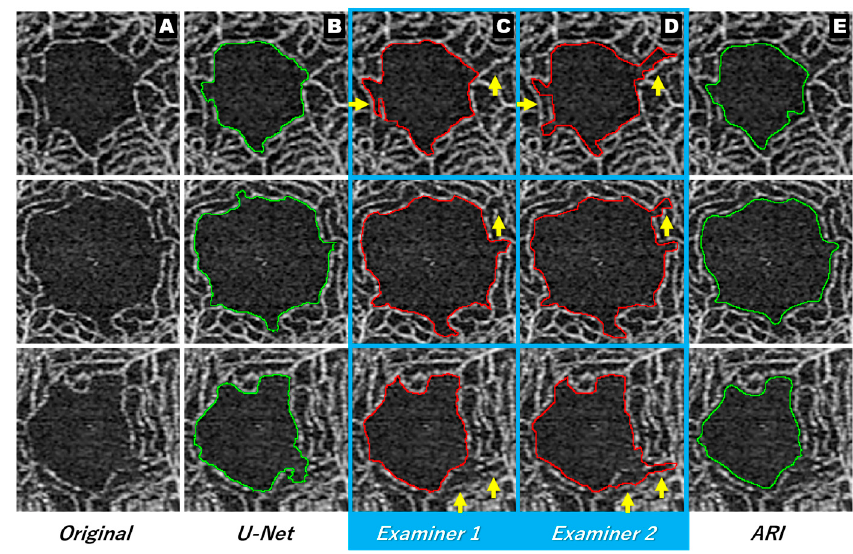
Figure 5. Extraction results for each method. Original image (column ( A )), U-Net (column ( B )). Examiners 1 and 2 (columns ( C ) and ( D )), ARI (column ( E )). There is a difference in the recognition of unevenness between the manual methods (Arrows in columns ( C , D )). ARI: Advanced Retina Imaging.